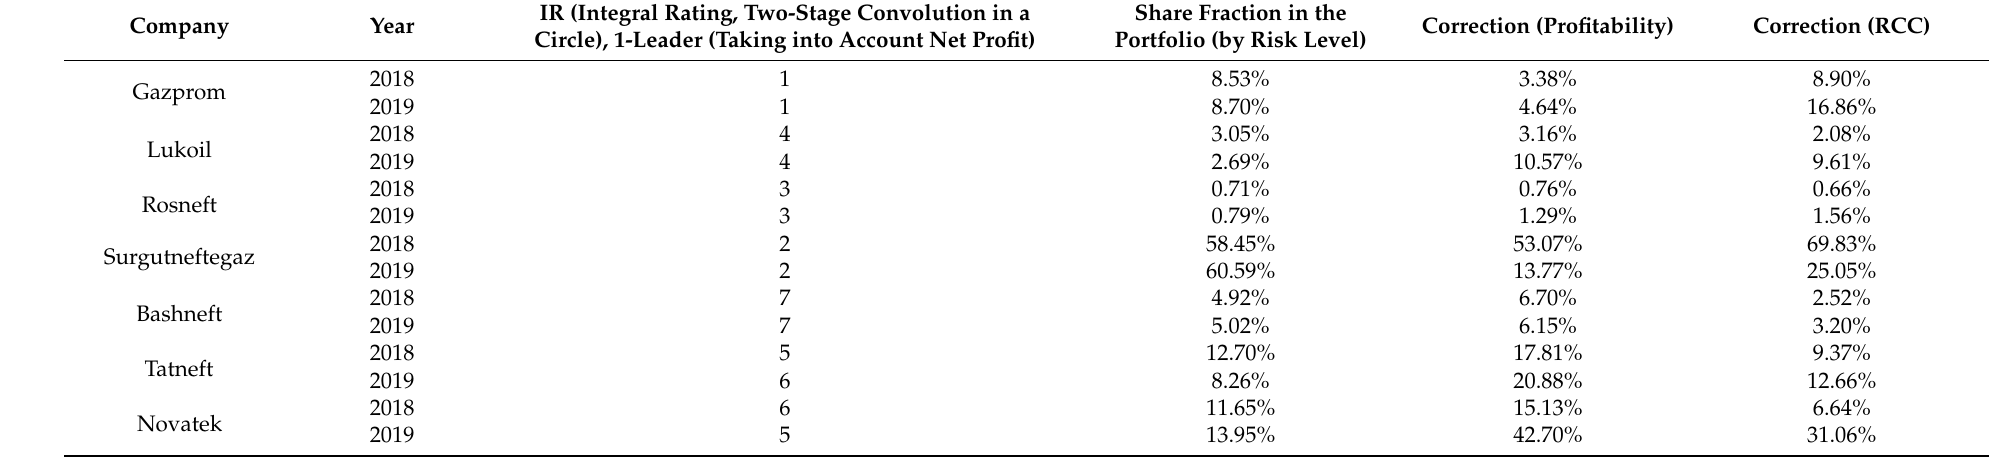
Table 2. Integrated rating